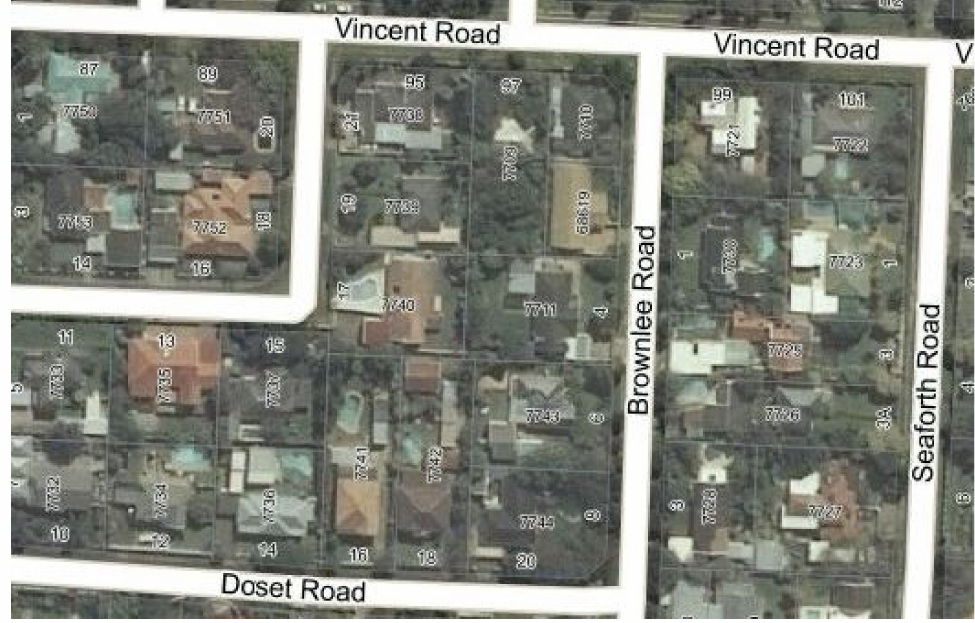
Figure 7. 1map Online GIS [21] overlay over rectified imagery of a suburb known as Vincent Heights in a formal cadastre area in East London, Eastern Cape Province, at scale 1:2000